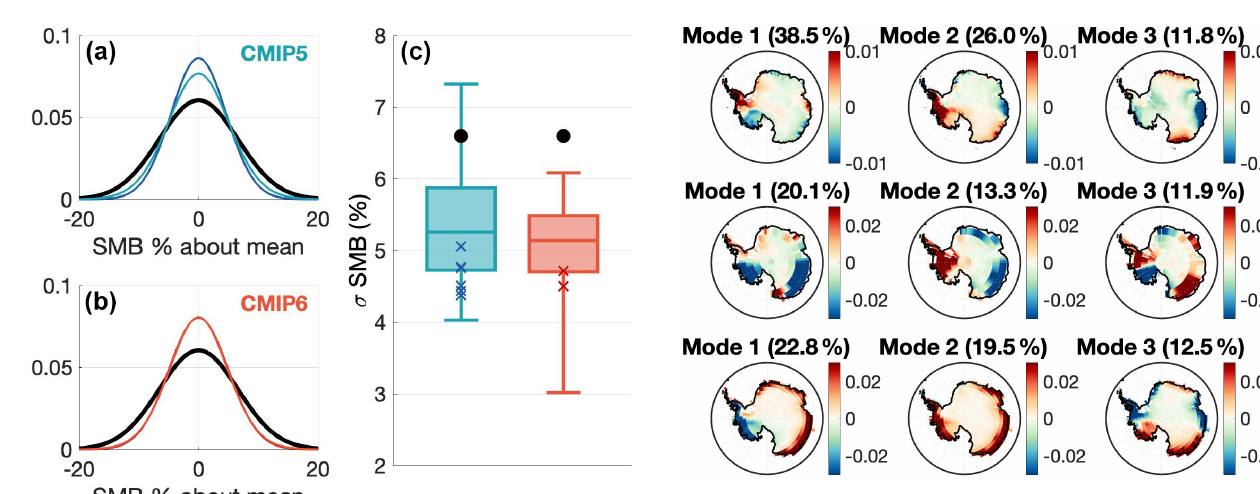
Figure 6. EOF analysis plots of the top three modes of variabil- ity for (a) the reconstruction, (b) a relatively high scoring model (CMCC CM), and (c) a low scoring model (CESM1 WACCM). Note that the scale for the model EOFs is 3 × that of the recon- structed